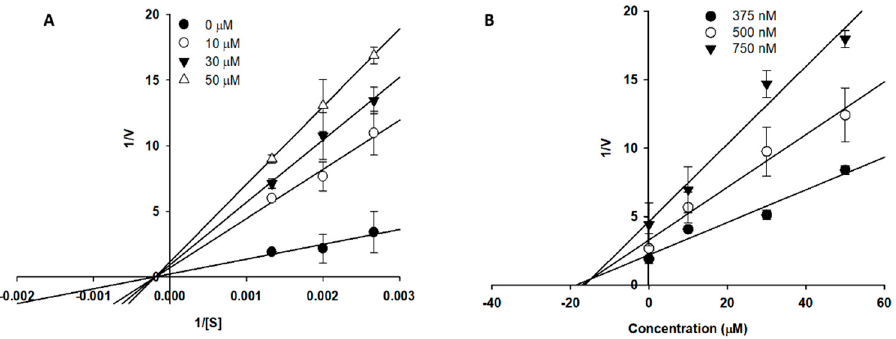
Figure 5. Lineweaver-Burk plot ( A ) and Dixon plot ( B ) for the inhibition of BACE1 by luteolin.